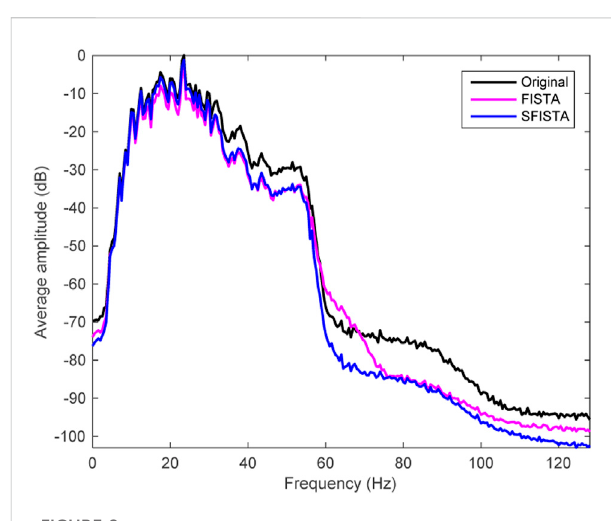
FIGURE 8 Average amplitude spectrum from original data, interpolated with FISTA and SFISTA